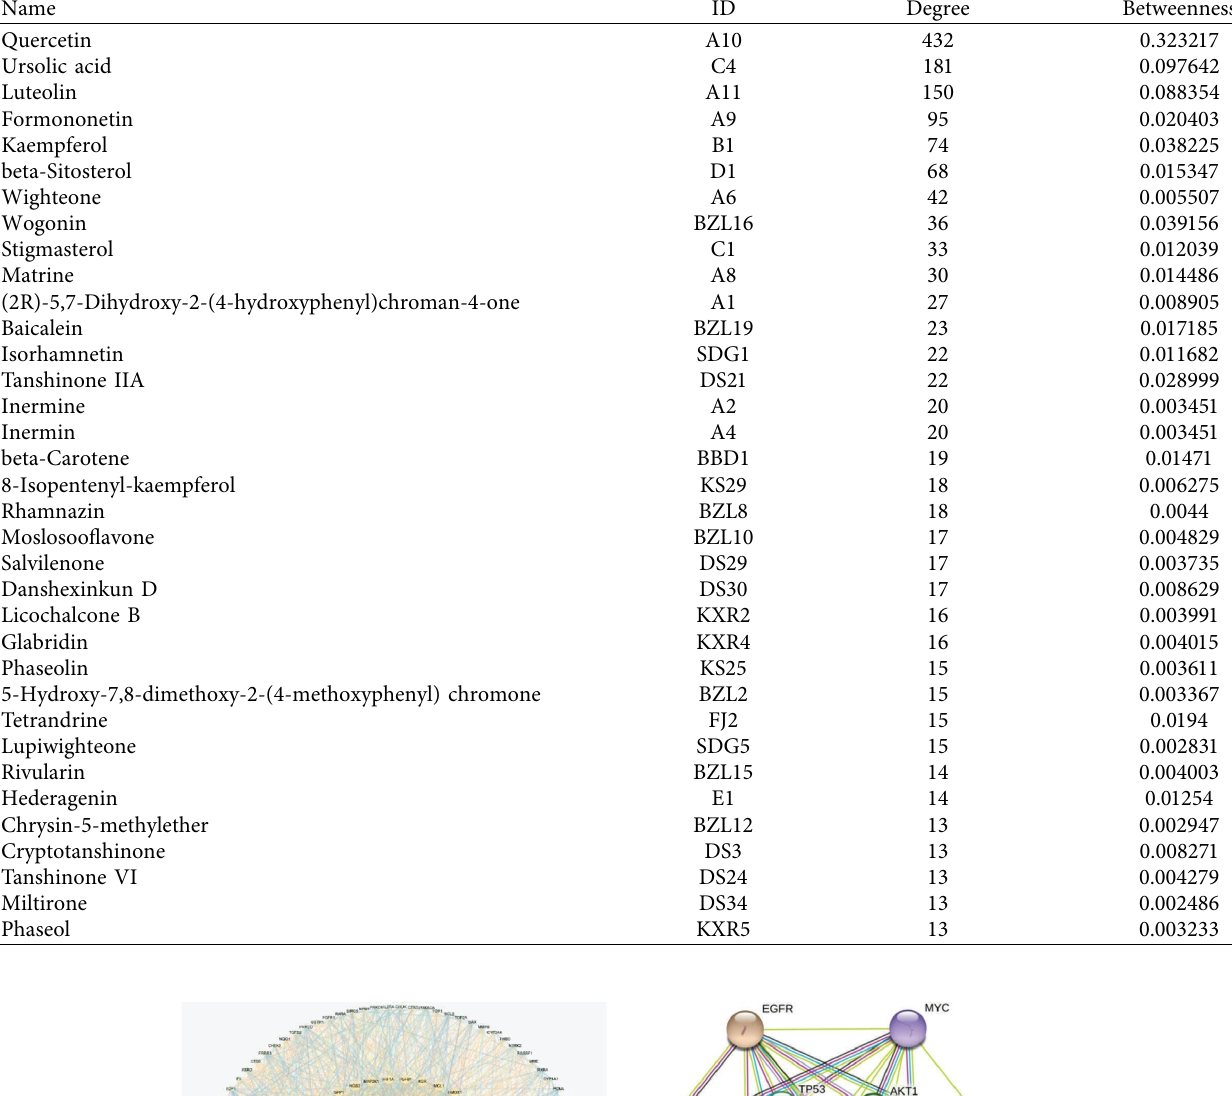
Table 2: Tirty-fve main potential active ingredients in SLC.